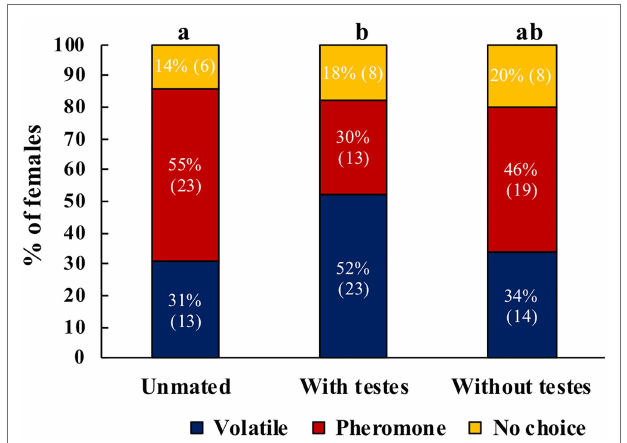
FIGURE 5 | Response of unmated A. ludens females ( N = 42), mated with intact males ( N = 44), or mated with testectomized males ( N = 41) to host volatiles or male pheromone. Different letters indicate significant differences between treatments. Numbers within parenthesis represent sample size.